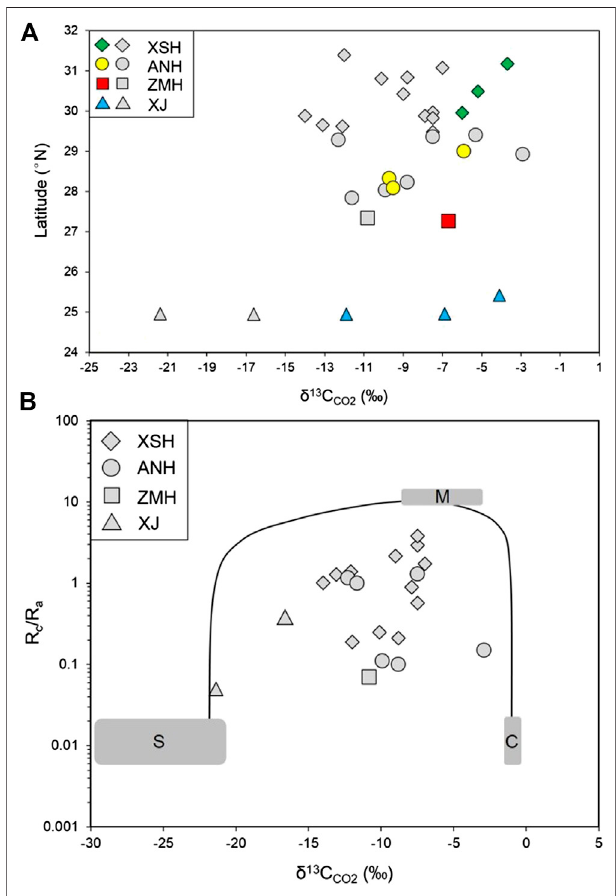
FIGURE 6 | (A) Plot of the δ 13 C CO2 values from south to north along the XXFS. (B) R c /R a vs . δ 13 C CO2 plot showing mixing of the end-members of mantle (M), crust (C), and sediment (S) of the bubbling gas samples in the XXFS. The colour symbols are data from bubbling hot-spring gas in this study.Thegreysymbolsarehot-springgasdatareportedinShenetal.(2007) and Zhou et al. (2015). The He-C isotopic data in June 2009 were selected in this study in consideration of the signi fi cant in fl uence of earthquake on the variations of He-C isotopic ratios (Zhou et al.,